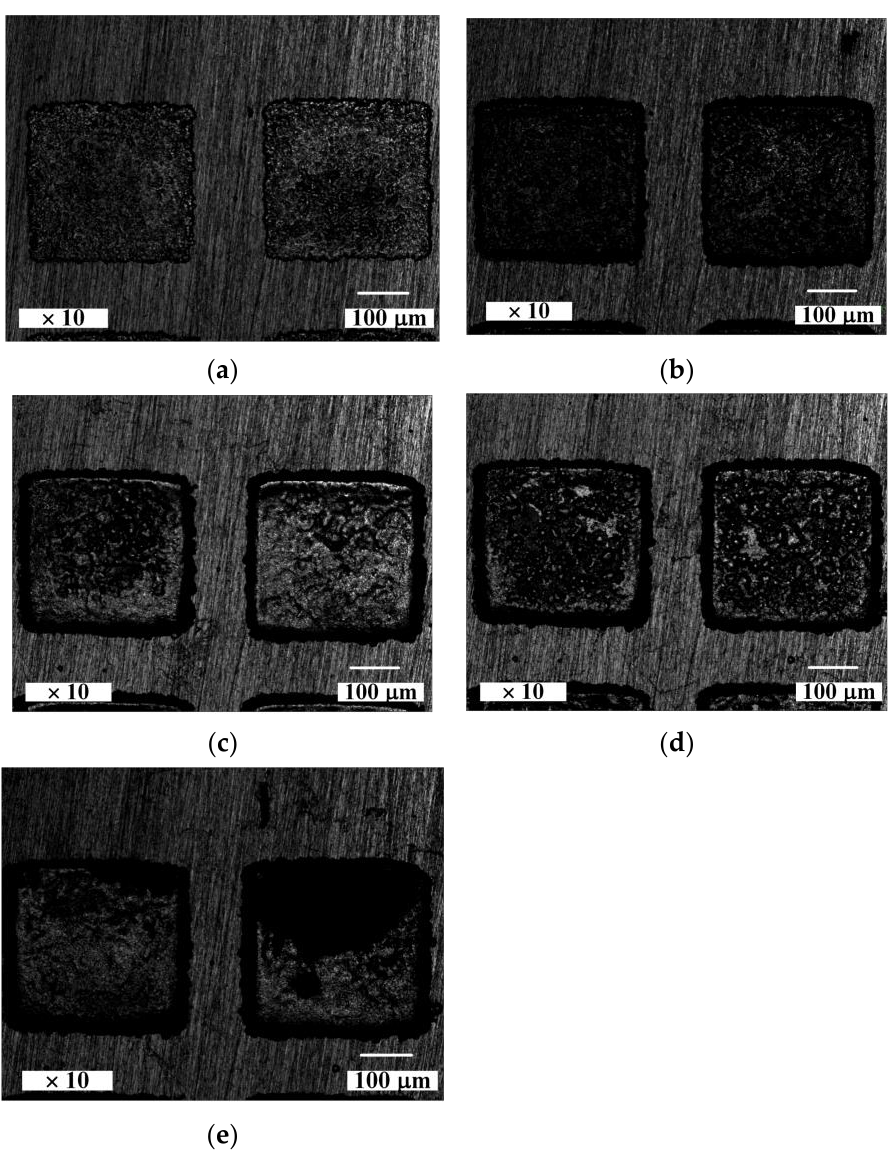
Figure 7. Shape change according to the number of repeated cycles of the DEE process cycle (etching voltage: 10 V, etching time: 7 s): ( a ) once; ( b ) five times; ( c ) 10 times; ( d ) 15 times; and ( e ) 20 times.